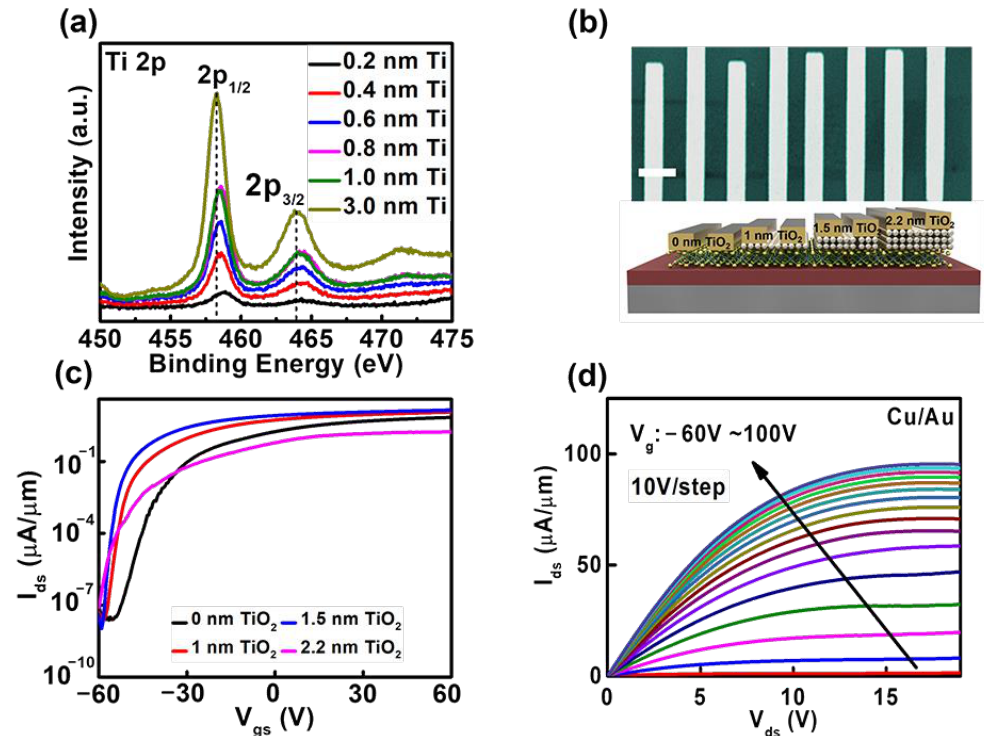
Figure 3. ( a ) Ti 2p spectra of TiO 2 with different thicknesses; ( b ) SEM image and schematic diagram of the back-gated Cu-TiO 2 -MoS 2 FETs with various TiO 2 thicknesses (0, 1, 1.5 and 2.2 nm) (scale bar = 5 µm); ( c ) transfer characteristics of the devices for various TiO 2 thicknesses with L being 3 µm and V ds being 1 V; ( d ) output characteristics of the Cu-TiO 2 -MoS 2 FETs.